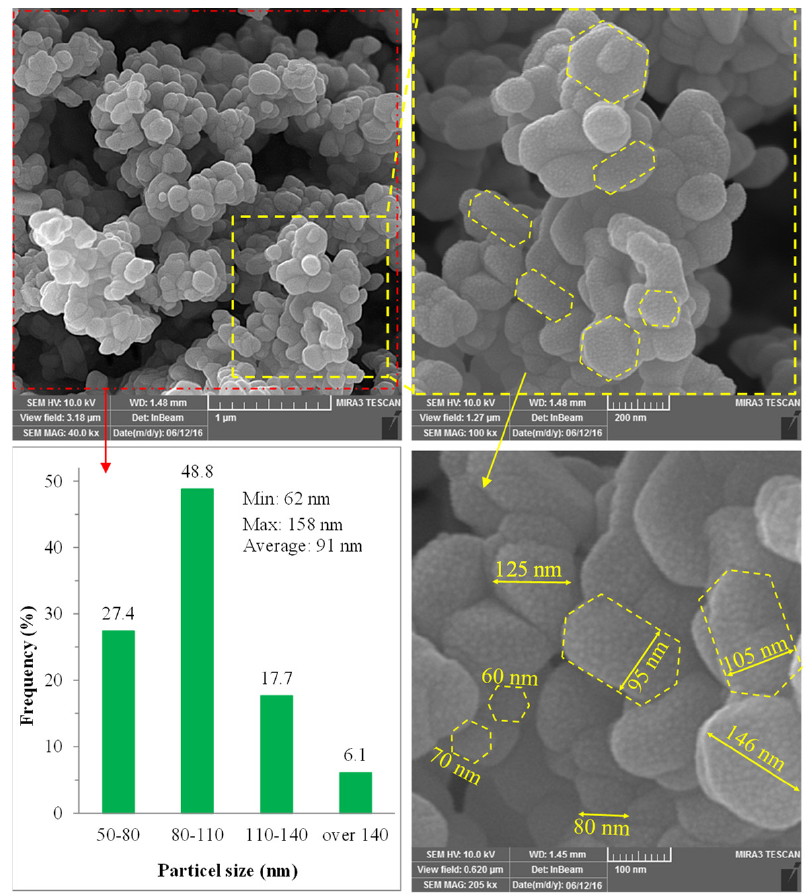
Figure 7. FE-SEM images and surface particle size distribution of calcium/titania-zirconia catalyst synthesised via sol-gel method at the optimum conditions suggested by GA.